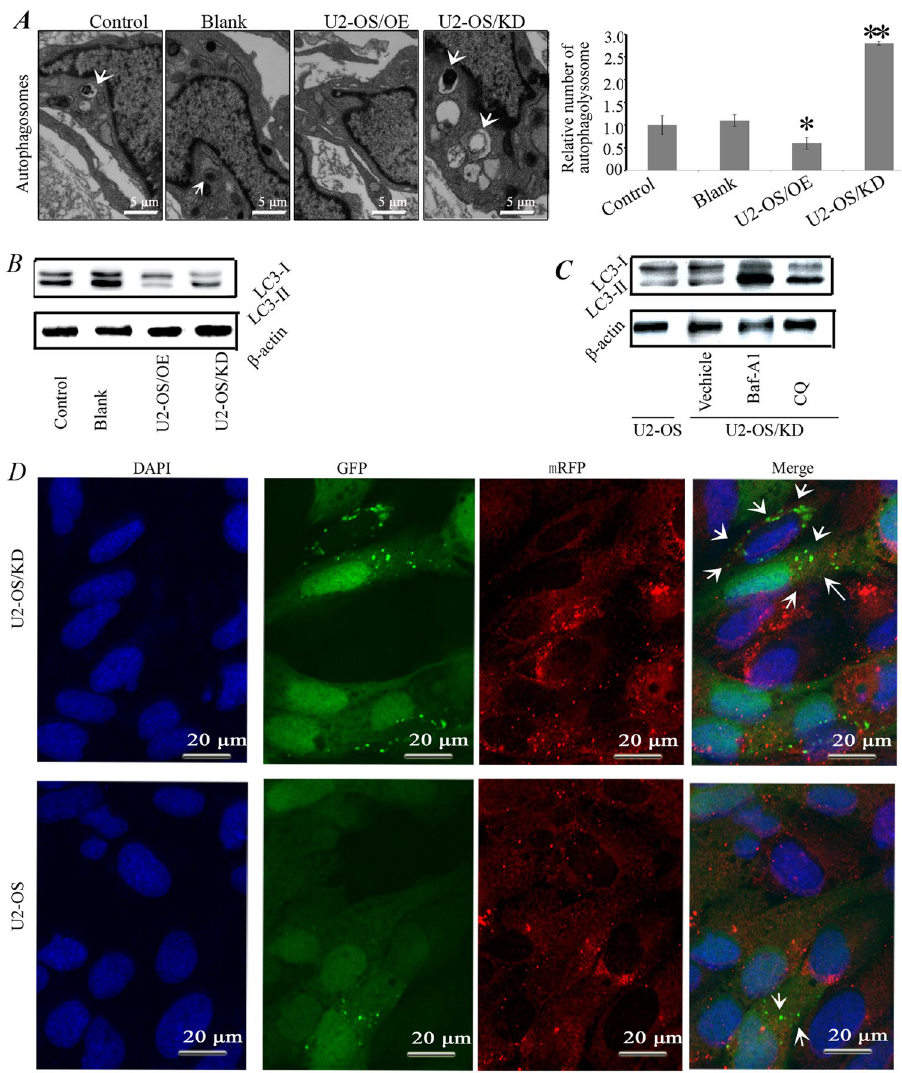
Figure 4. miR-140-5p suppressed autophagy in osteosarcoma cells. ( A ) Autophagy was evaluated in a blank group (untransfected cells), a control group (cells transfected with the control lentivirus), an OE group (overexpression of miR-140-5p) and a KD group (knocking down of miR-140-5p). Using TEM. The white arrows indicated autophagosomes. ( B ) Western blot analysis of the expression of LC3-II and LC3-I for U2-OS cells in control, blank, OE and KD groups. ( C ) Western blot analysis of the expression of LC3-II and LC3-I. Knocking down of miR-140-5p U2-OS cells (U2-OS/KD) were incubated with 20 µ M Choroquine or 10 nM Baf A1 for 12 hrs and then assessed by Western blot. ( D ) U2-OS/KD cells stably expressing mRFP-GFP-LC3 and then examined using confocal microscopy. The white arrows indicate